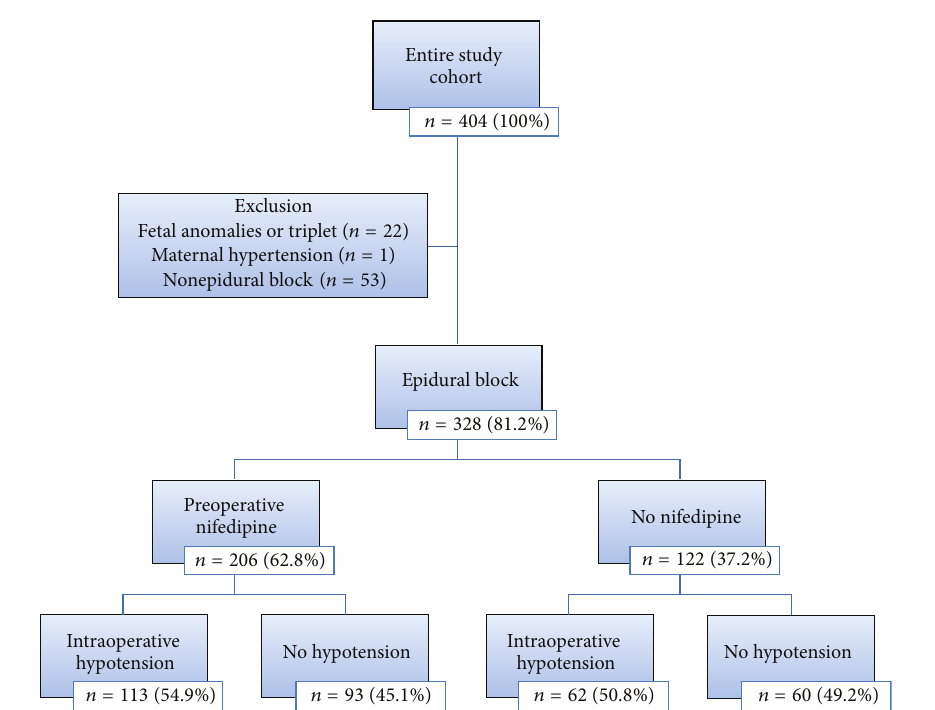
Figure 1: Flow chart illustrates subject enrollment and analysis. A total of 328 subjects were included for analysis in this retrospective cohort study. There was no difference in the incidence of intraoperative maternal hypotension with preoperative nifedipine in comparison with the without preoperative nifedipine (54.8% versus 50.8%, 𝑃 = 0.479